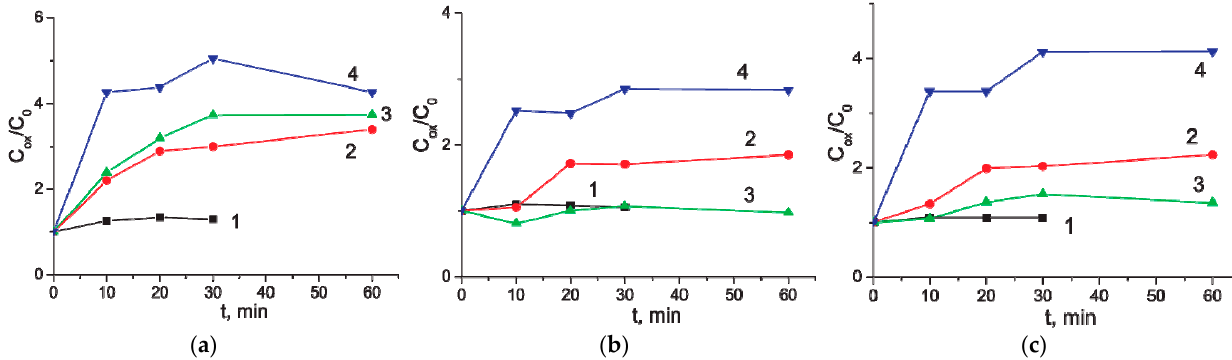
Figure 4. The C ox / C 0 ratio of MWCNT/Al versus the time of anodic oxidation. Potential of anodic oxidation was 3 V. Concentration of the electrolyte (aqueous Na 2 SO 4 solution), mol/L: 0, i.e., distilled water (trace 1), 0.005 (trace 2), 0.05 (trace 3), and 0.5 (trace 4). CV range: ( a ) From − 800 to 10 mV; ( b ) From − 10 to 800 mV; ( c ) From − 800 to 800 mV. Table 2. The C ox / C 0 ratio of MWCNT/Al for various time of anodic oxidation in the electrolyte of different concentration (aqueous Na 2 SO 4 solution). The potential of anodic oxidation was 3 V. Concentration of Na 2 SO 4 Solu-